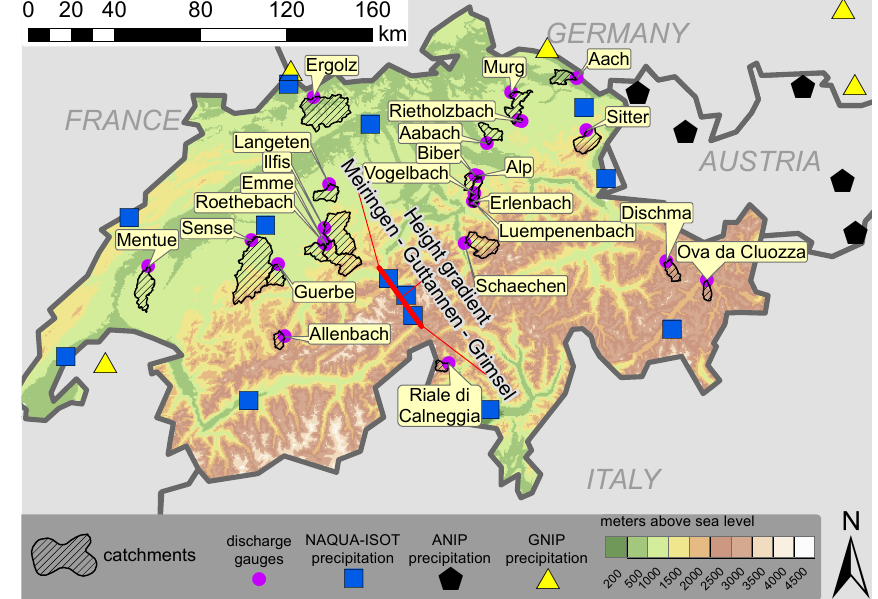
Figure 1. Map of the study area with elevation and catchment borders. The catchment that is not shown, Oberer Rietholzbach, is a subcatch- ment of the Rietholzbach catchment. The symbols indicate positions of isotope measurement sites of various